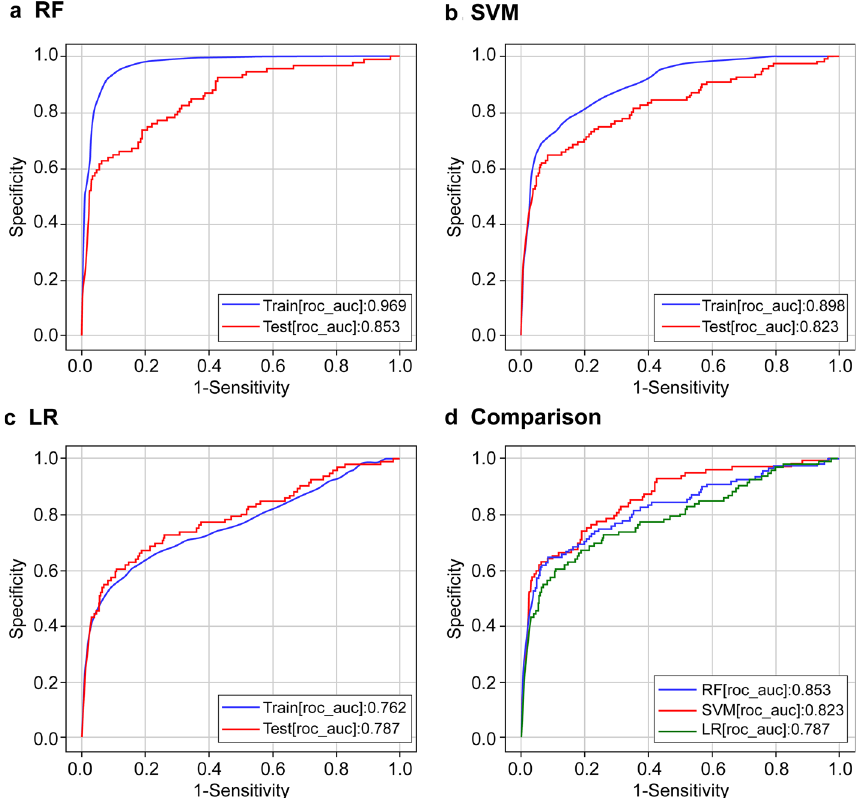
Figure 1. Prediction accuracy. ( a – c ) Accuracy of each machine-learning method. The blue line represents the accuracy in the training set, and the red line represents the accuracy in the test set. ( d ) Comparison of the verification data of the three machine-learning methods. The x-axis and y-axis represent the negative sensitivity and specificity in the ROC curve, respectively. The test accuracy depends on the extent to which the machine- learning model can correctly determine whether the CPOT score was < 2 or > 3. Accuracy is represented by AUROC; area of 1 represents the perfect test and that of 0.5 represents an inconclusive test.